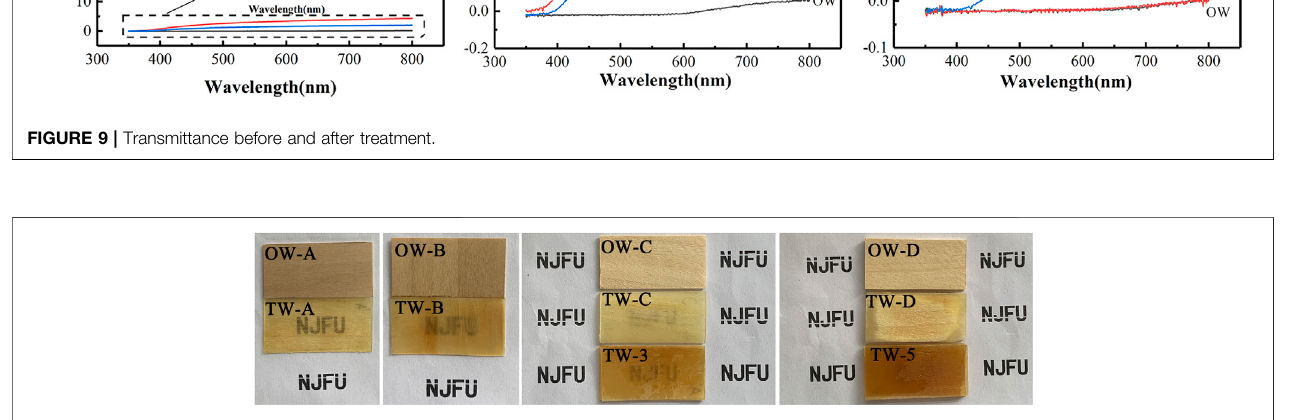
FIGURE 10 | Macroscopic observation diagram of transparent